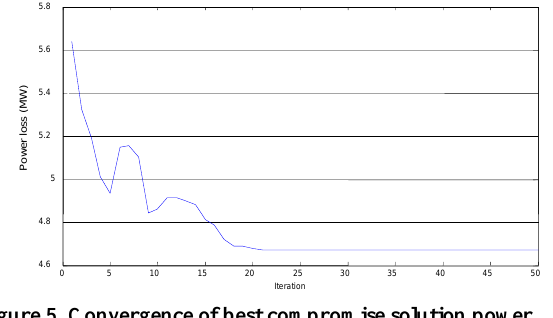
Figure 5. Convergence of best compromise solution power